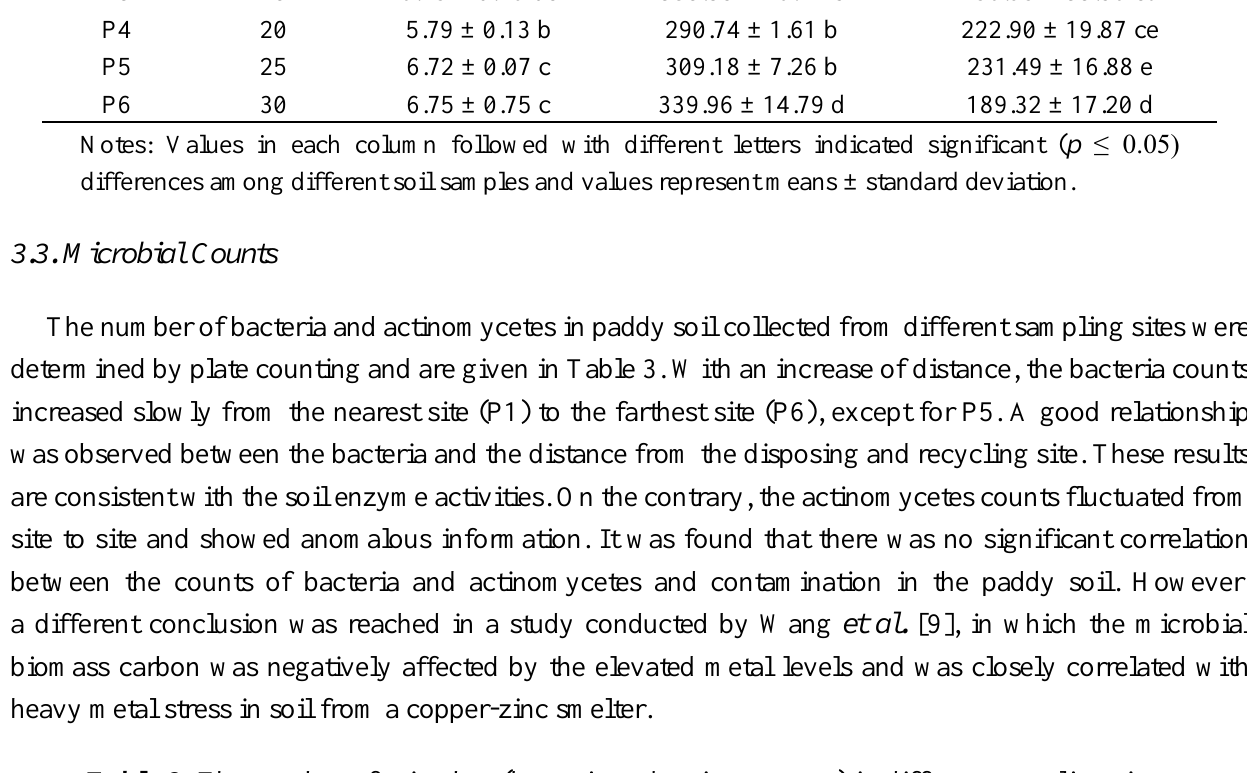
Table 3. The number of microbes (bacteria and actinomycetes) in different sampling sites. Sampling